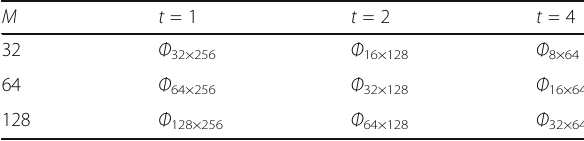
Table 1 Different dimensional measurement matrices Φ ( t )